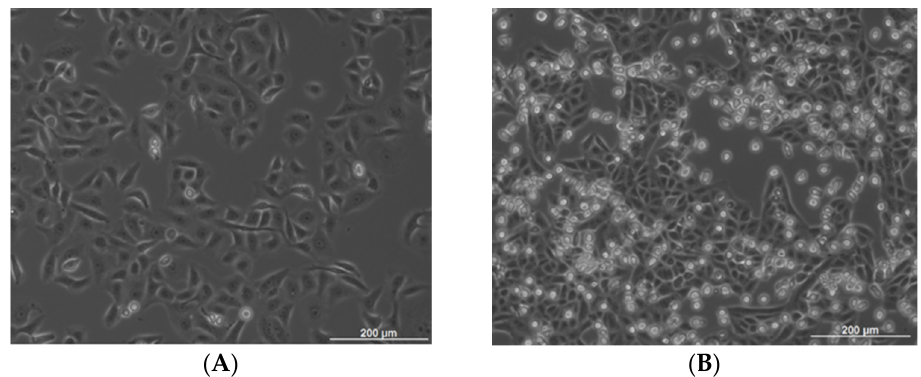
Figure 2. Cell line cultivation : ( A ) PCI-13 monoculture and ( B ) LUVA/PCI-13